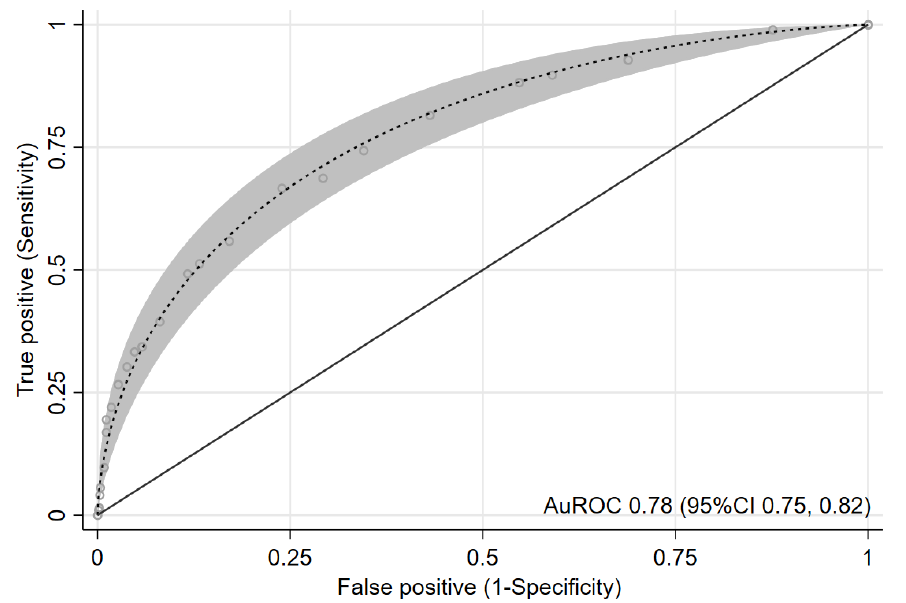
Figure 2. ROC curve (parametric) and 95% confidence band for prediction of AKI by the derived score. Abbreviations: AKI, acute kidney injury; AuROC, area under the receiver operating characteristic curve; CI, confidence interval.